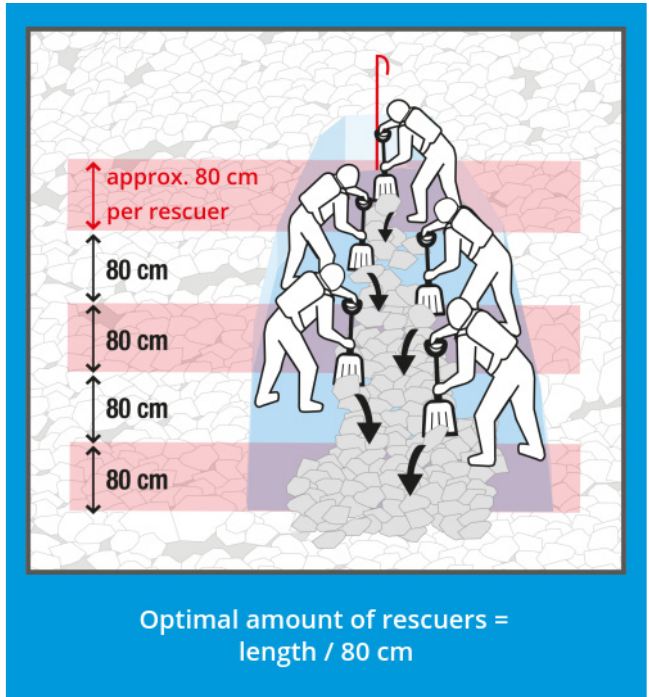
Figure 6. Optimal number of rescuers for efficient excavation applying the snow conveyor belt technique [16]. Illustration: www.MountainSafety.info as of 31 December 2021, reprinted with permission of MountainSafety.info.